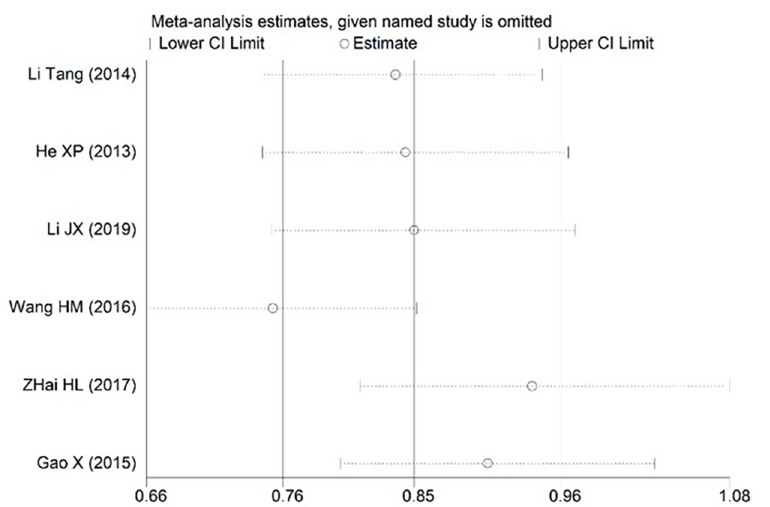
Fig 8. Sensitivity analysis for each breastfeeding duration > 0.5 h.